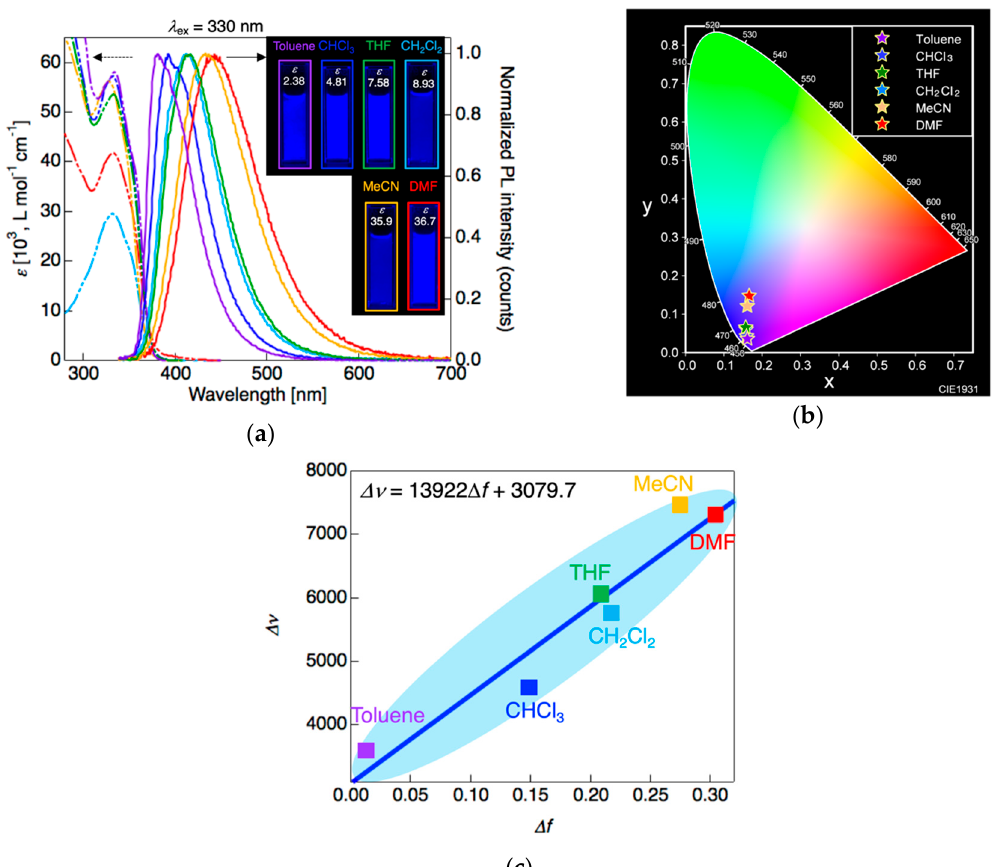
Figure 5. ( a ) UV-vis absorption and photoluminescence (PL) spectra ( λ ex = 330 nm) of S - 2b in various organic solvents recorded at concentrations of 1.0 × 10 − 5 mol L − 1 and 1.0 × 10 − 6 mol L − 1 , respectively. Inset: PL colors under UV irradiation ( λ ex = 365 nm). ( b ) CIE color diagram with positions of PL observed in various solvents upon excitation at 330 nm. (c ) Lippert-Mataga plot.